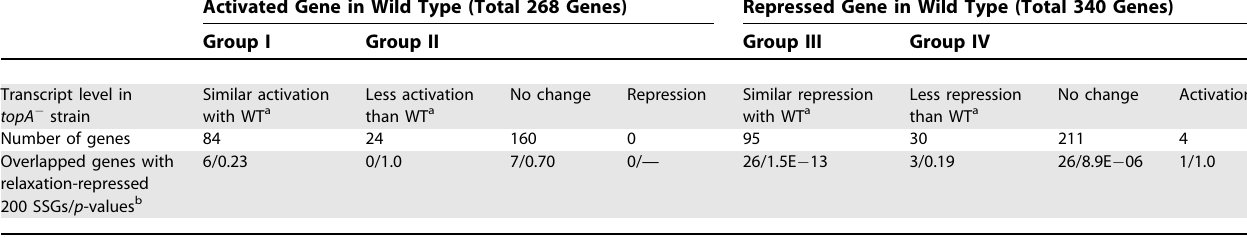
Table 2. A topA -Dependent Classification of Differentially Expressed Genes Activated Gene in Wild Type (Total 268